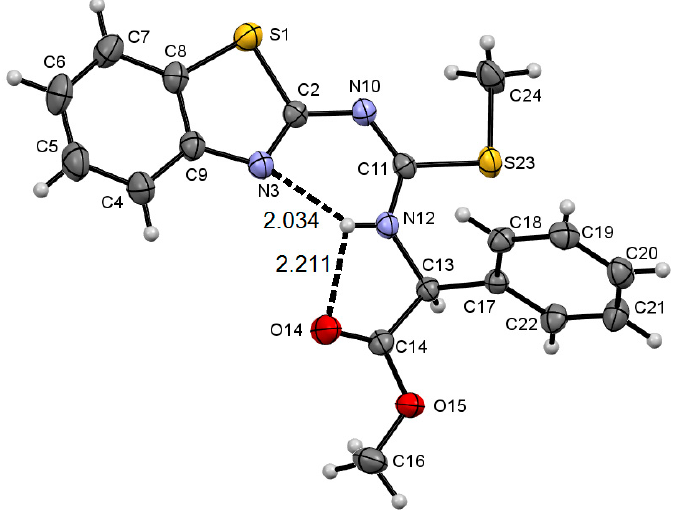
Figure 4. X-ray diffraction structure of compound 8c . Bond length (Å): S(1)–C(2) 1.753(2), N(3)–C(2) Figure 4. X-ray di ff raction structure of compound 8c